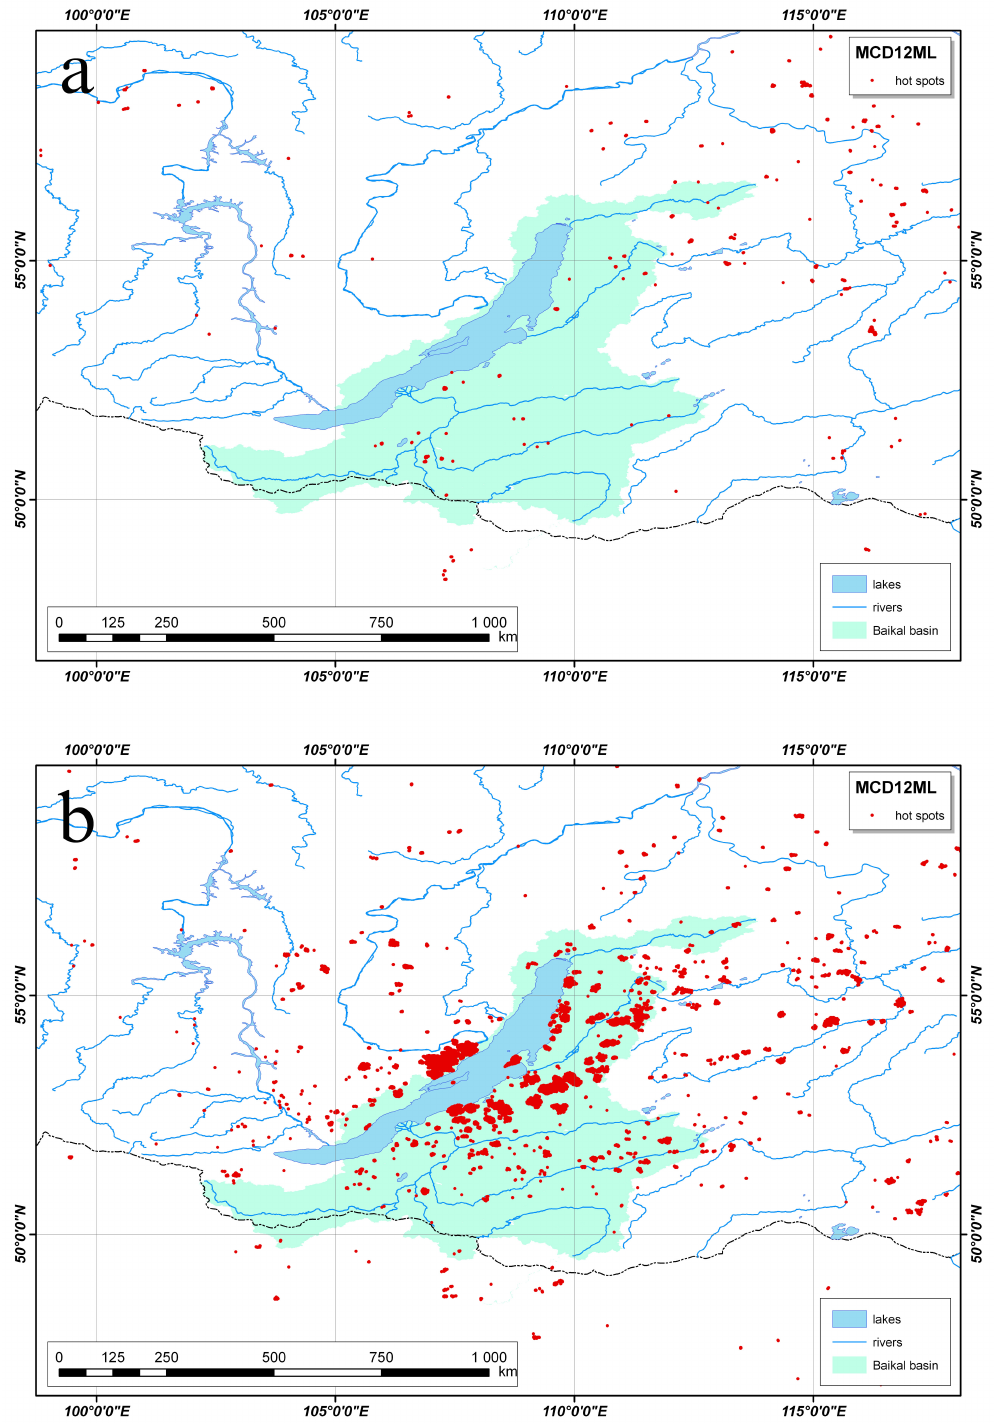
Figure 13. The comparison between spatial distributions of July–August wildfires (MCD14ML active fires, AF) in the relatively wet 2010 summer ( a ) and in the abnormally dry 2015 summer ( b ) is